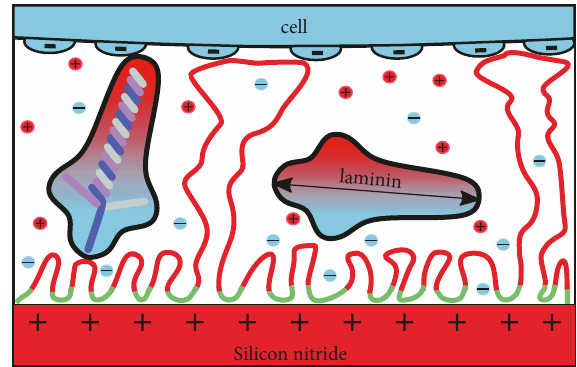
Figure 5: Sketch of a negatively charged cell surface in contact with a PEI/laminin-coatedsilicon nitride surface.Protonated amino groups generate the positive charge of the flexuous PEI polymer chain (red segments). The positive charges on the silicon nitride surface increase the pH over the double layer length and thus deprotonate the PEI polymer (green segments). The segments discharged are bound to the surface by van der Waals forces. Flexuous PEI loops with an approx. length of 100 nm can span the laminin layer and create adhesion between the surfaces. The maximum length of the elongated laminin protein is approx. 80 nm (double